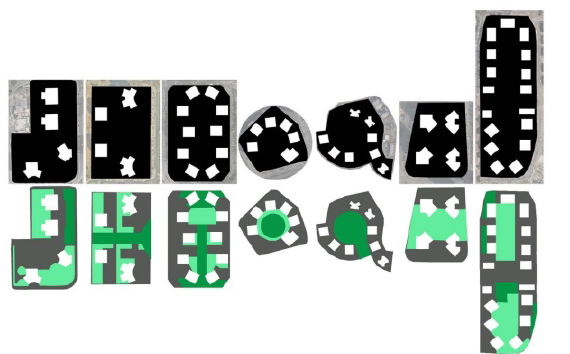
Figure 7. The gray/green nolli map of 7 exemplary